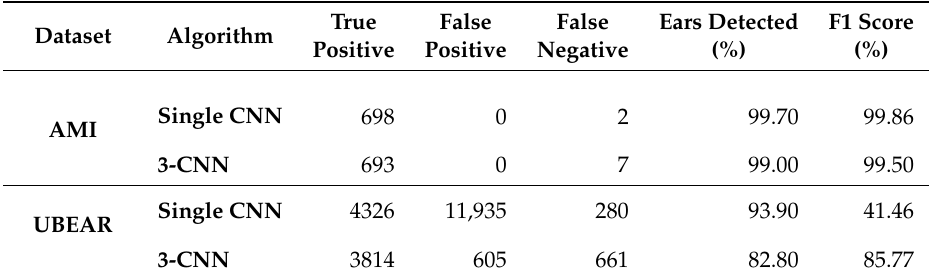
Table 4. Single vs. 3-Convolutional Neural Network (CNN) inference performance, showing how both systems vary greatly when tested against different data types.